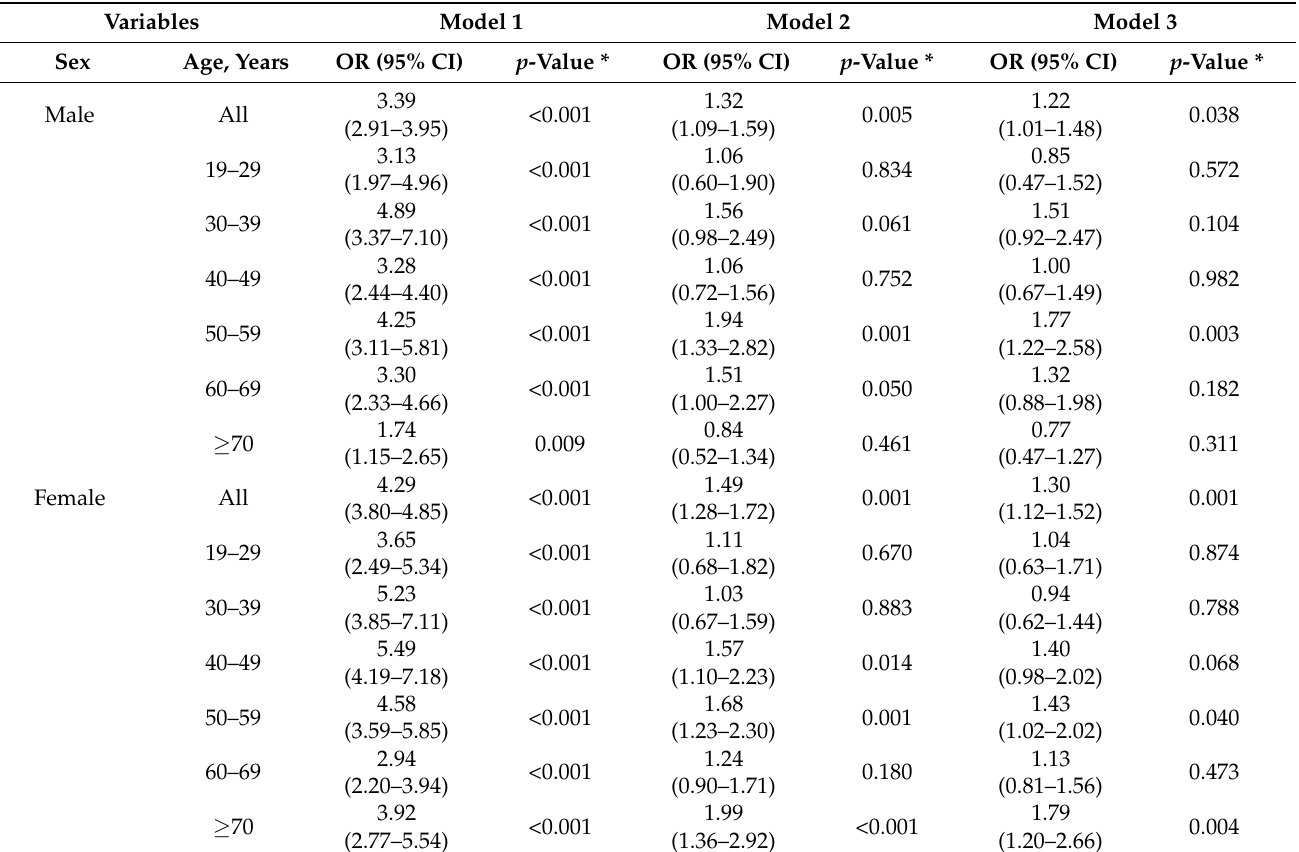
Table 3. Association between unmet dental care needs and use of dental checkups according to sex and age.